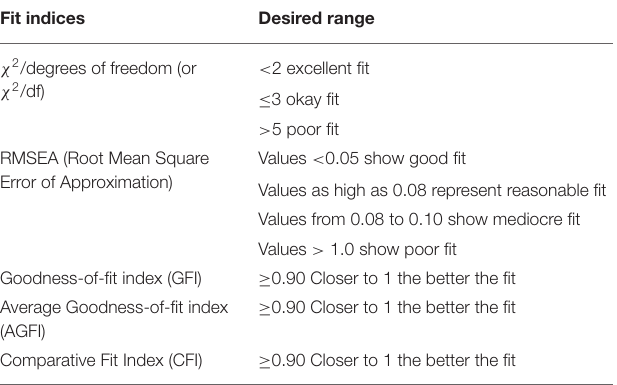
TABLE 4 | Recommended goodness of fit metric.